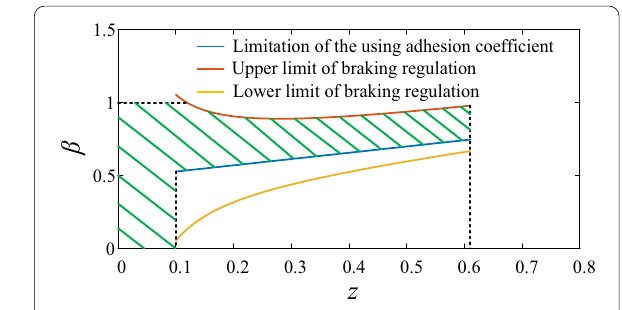
Figure 6 The feasible region of the distribution